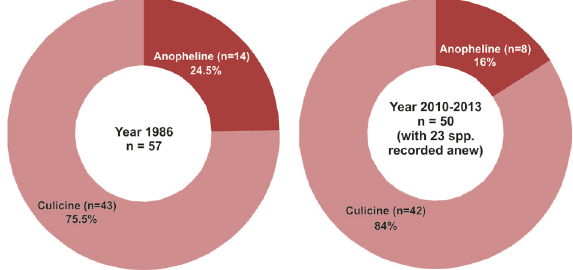
Figure 2. Ratio between anopheline and culicine species collected during 1986 and